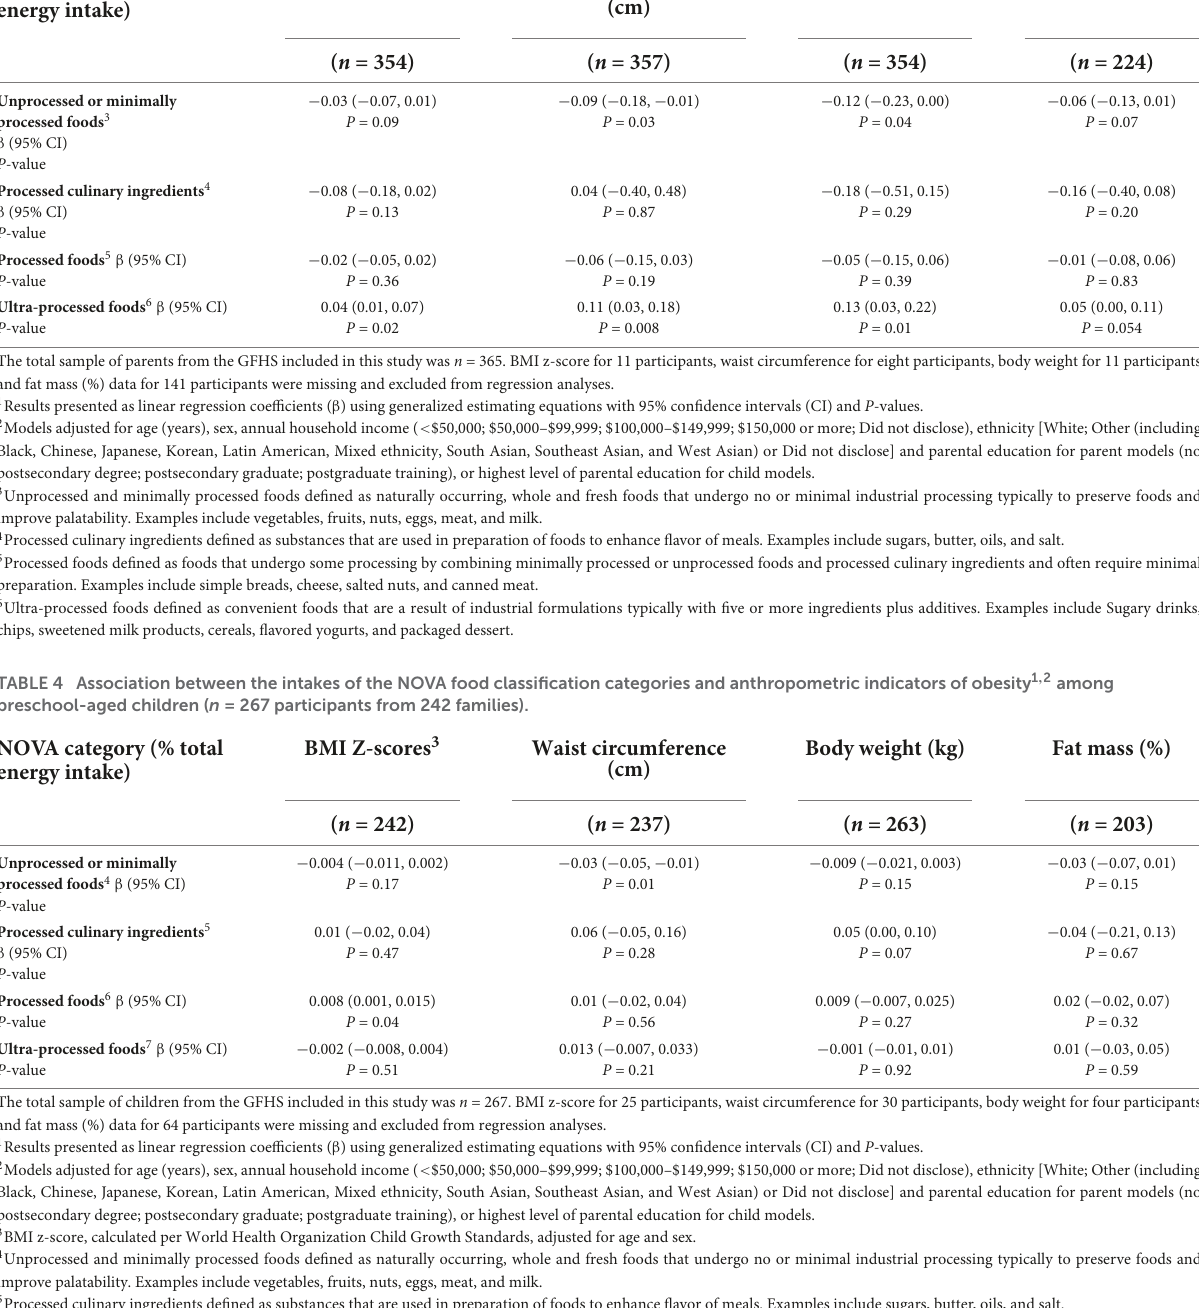
TABLE 3 Association between the intakes of the NOVA food classification categories and anthropometric indicators of obesity 1 , 2 among parents ( n = 365 participants from 242 families). NOVA category (% total energy